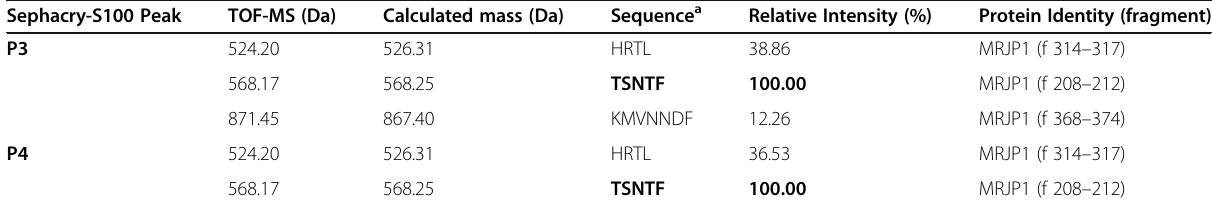
Table 1 Peptides identified by MALDI-TOF/MS in the Sephacryl-S100 active peaks of HP-p2 hydrolysates Sephacry-S100